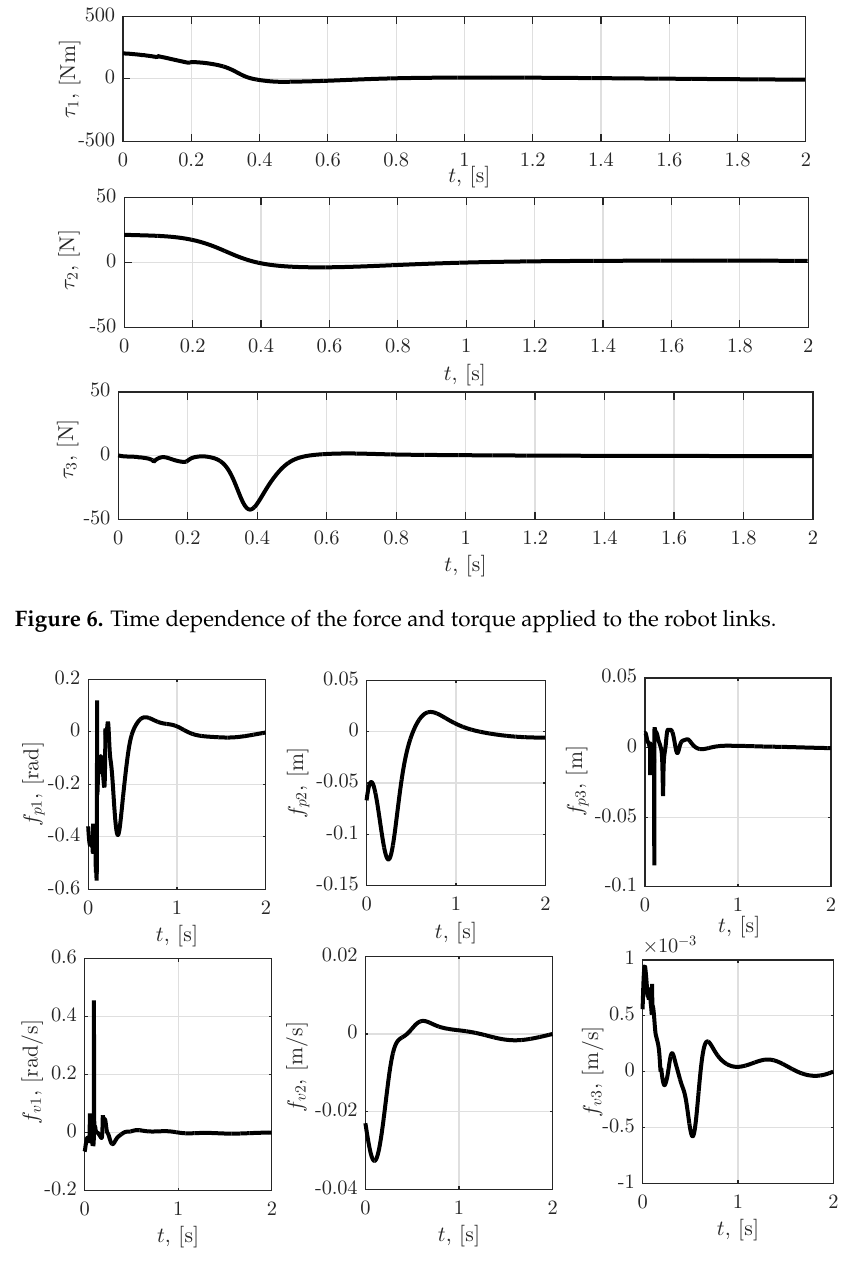
Figure 7. Time dependence of the “worst case” sensor faults obtained by proposed